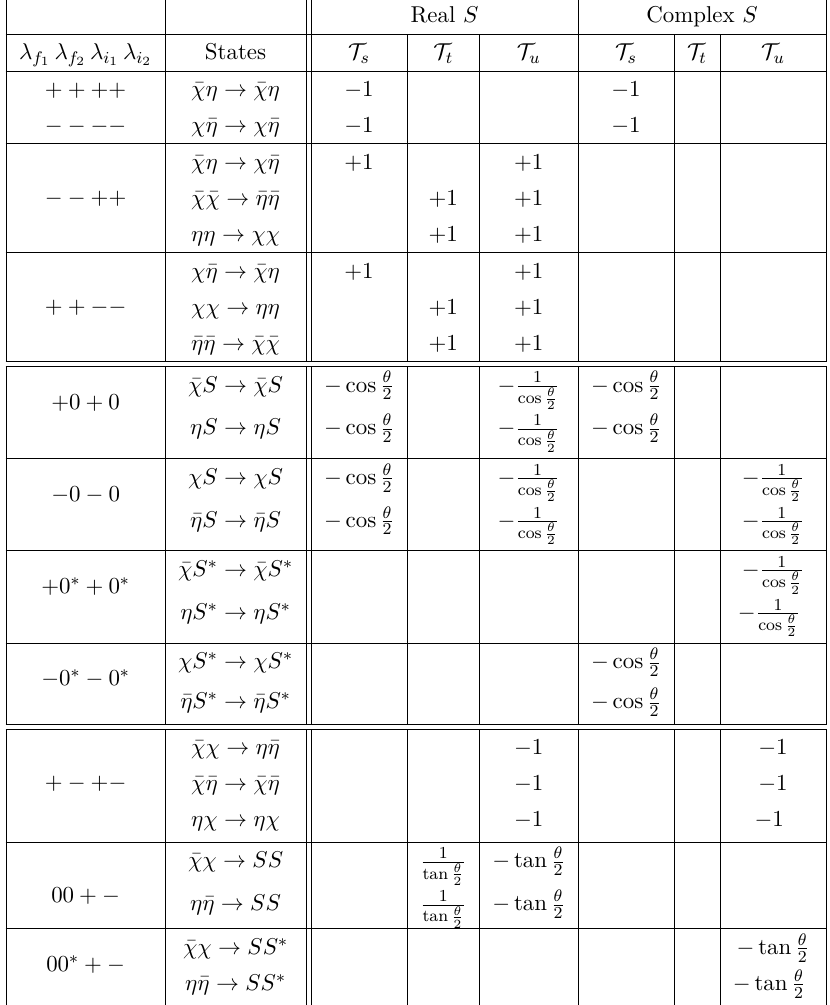
Table 2 . Lorentz part of the amplitudes for the models of the first class divided by y 2 . In the complex scalar case also the 0 ∗ 0 ∗ + − amplitudes are zero. In the helicity amplitudes the notation 0 ∗ indicates the scattering involving the conjugate of the scalar S